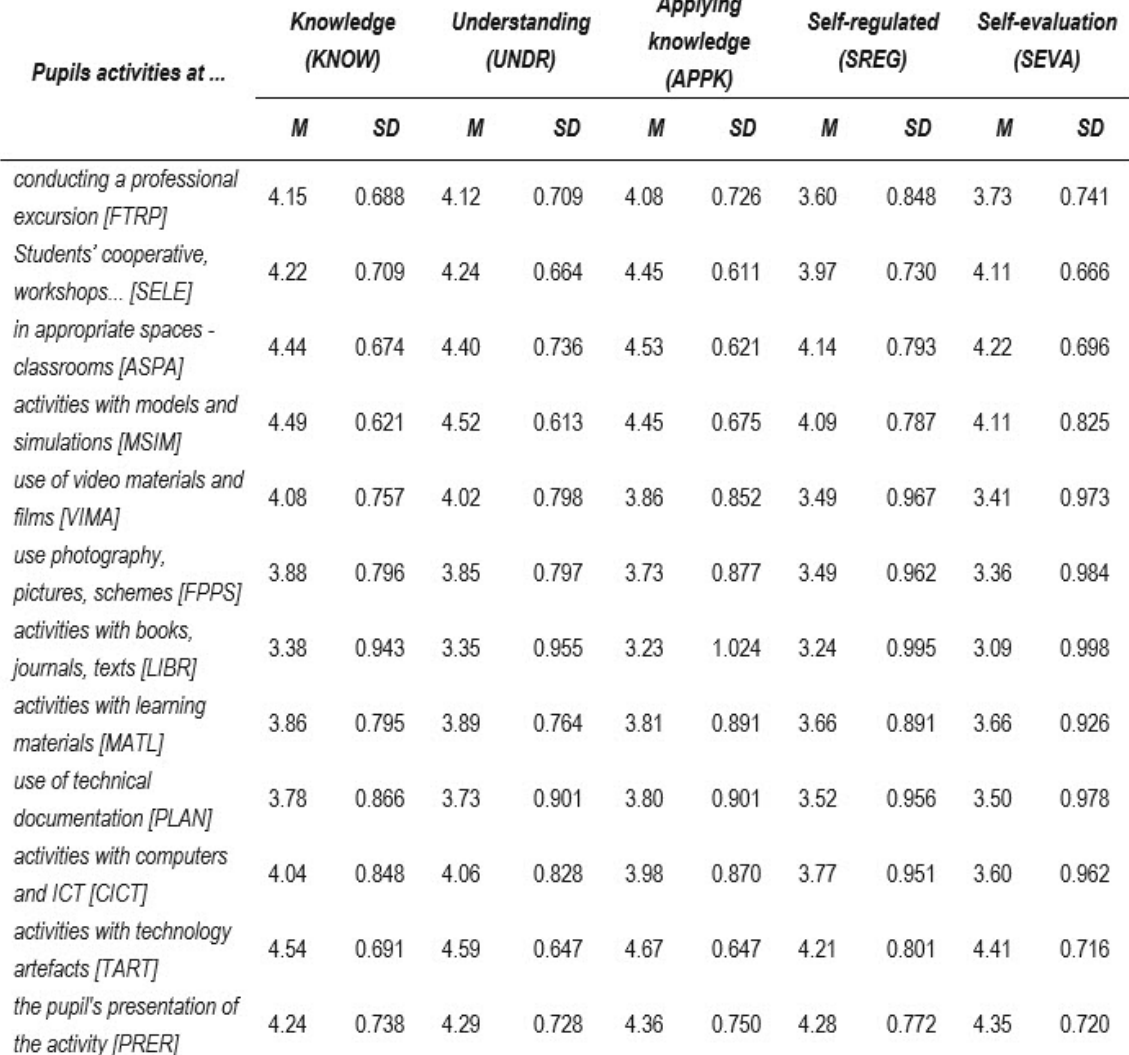
Basic parameters of descriptive statistics (M, SD) for the estimates of the effect of contextual elements on a pupils’ achievements: knowledge of content (KNOW), content understanding (UNDR), knowledge application (APPK), ability of self-regulated learning (SREG), self-evaluation of achievements